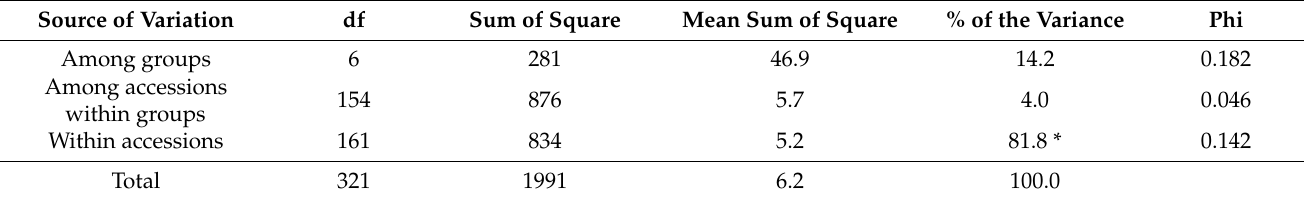
Table 4. Analysis of molecular variance (AMOVA) for 161 Japanese plum-type accessions clustered in seven groups. Source of Variation df Sum of Square Mean Sum of Square % of the